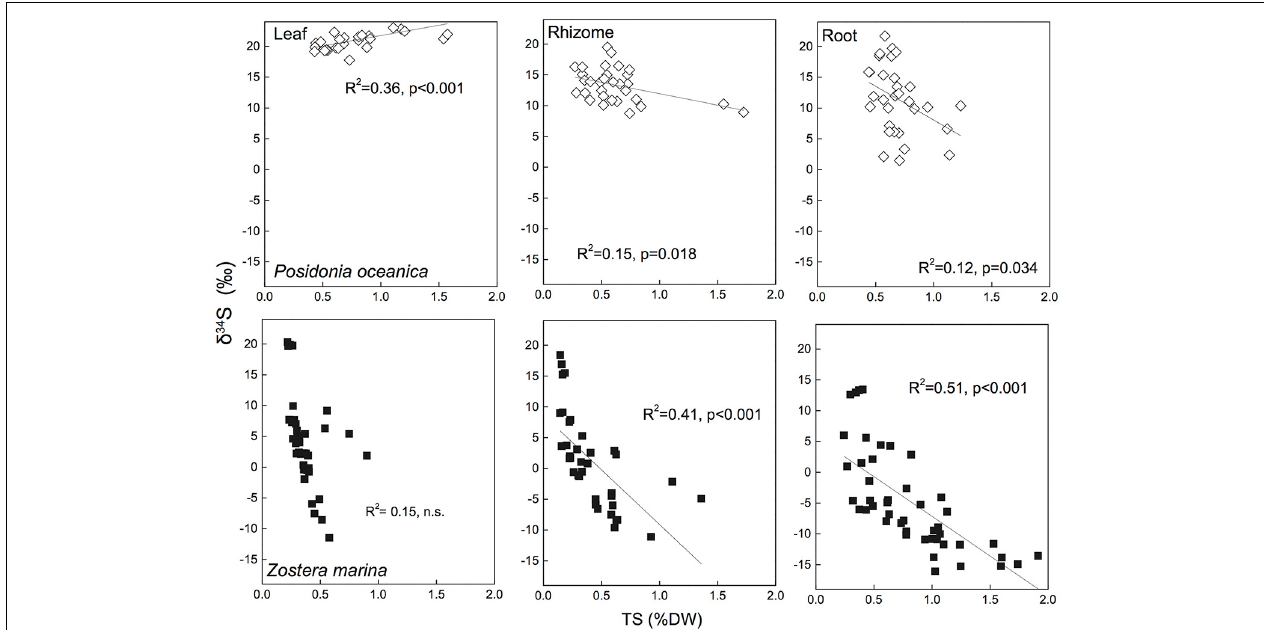
row) and roots (right row). The correlation coefficient ( R 2 ) and p -value for the linear regressions are given. The references are given in the supplementary